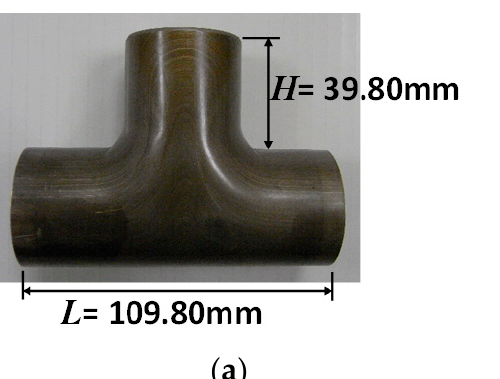
12 of 19 Figure 13. Comparison of loading path between the manual set from experience and the fuzzy inference model (250 °C), p: internal pressure, ∆ H : counterpunch displacement, ∆ L : axial penetra- tion.